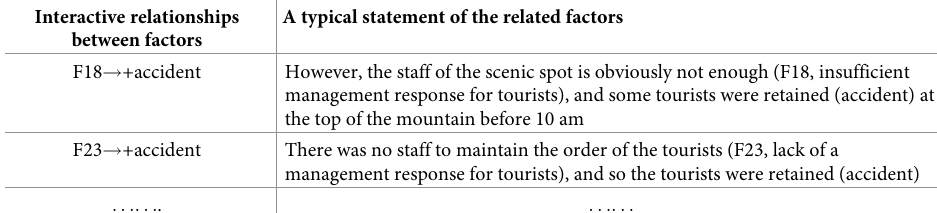
Table 3. The typical statements of the related factors and their interactive relationships of occurrence mechanism of accidents. Interactive relationships between factors